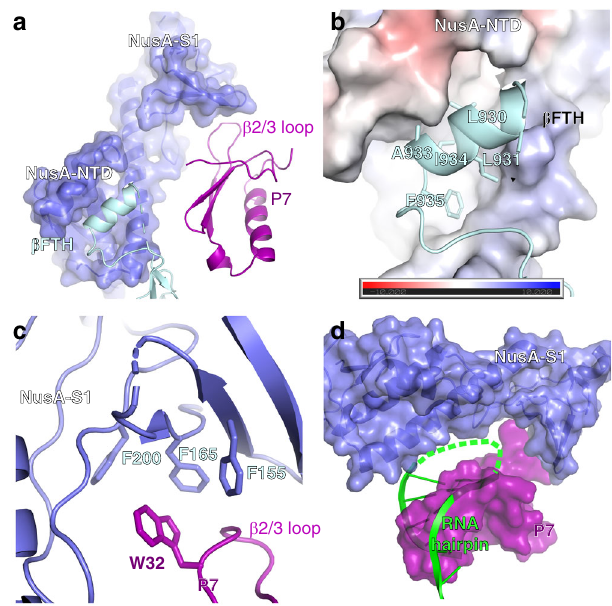
Fig. 4 NusA interacts with P7 to enhance its antitermination effect. a NusA interacts with both RNAP β FTH and P7. b NusA interacts with the RNAP β FTH through a hydrophobic groove on its NTD domain. The electrostatic potential surface of NusA was generated using APBS tools in Pymol. c The detailed interactions between NusA and P7. d Structural superimposition between E. coli NusA-PEC (PDB: 6FLQ) and Xoo P7-NusA-TEC suggests that P7 blocks the RNA-hairpin binding site of